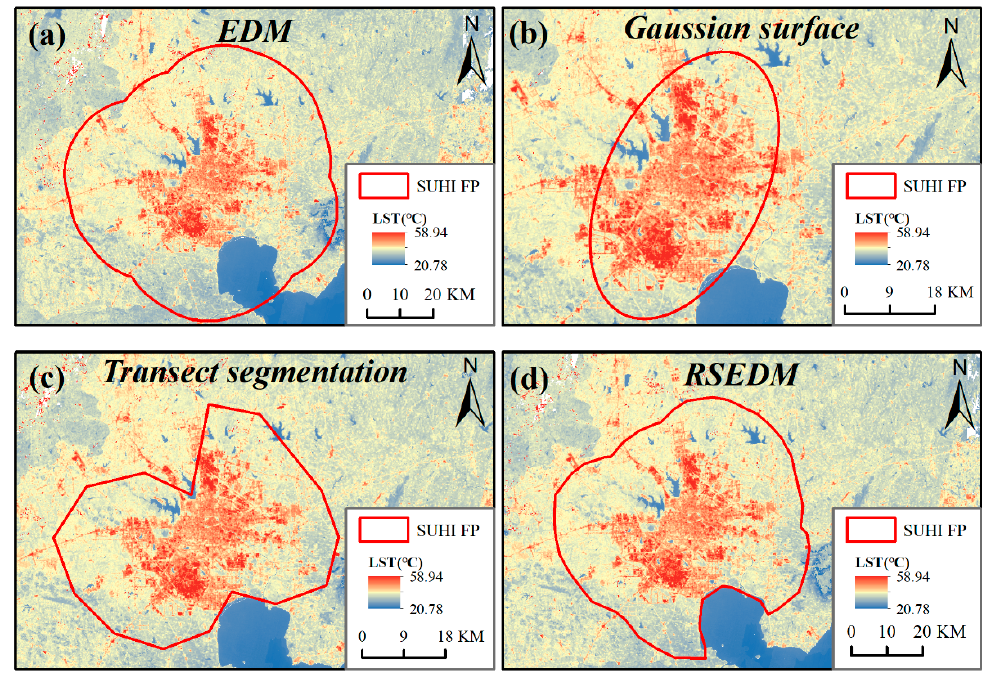
Figure 13. Surface urban heat island calculated by different methods based on different calculation principles. ( a ) Exponential decay model; ( b ) Gaussian surface method; ( c ) transect segmentation method; ( d ) rotational-scan exponential decay model.